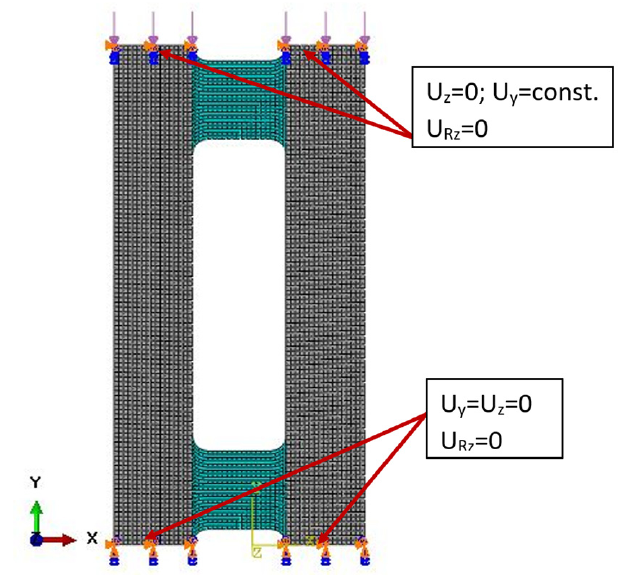
Figure 4. Numerical model with boundary conditions.